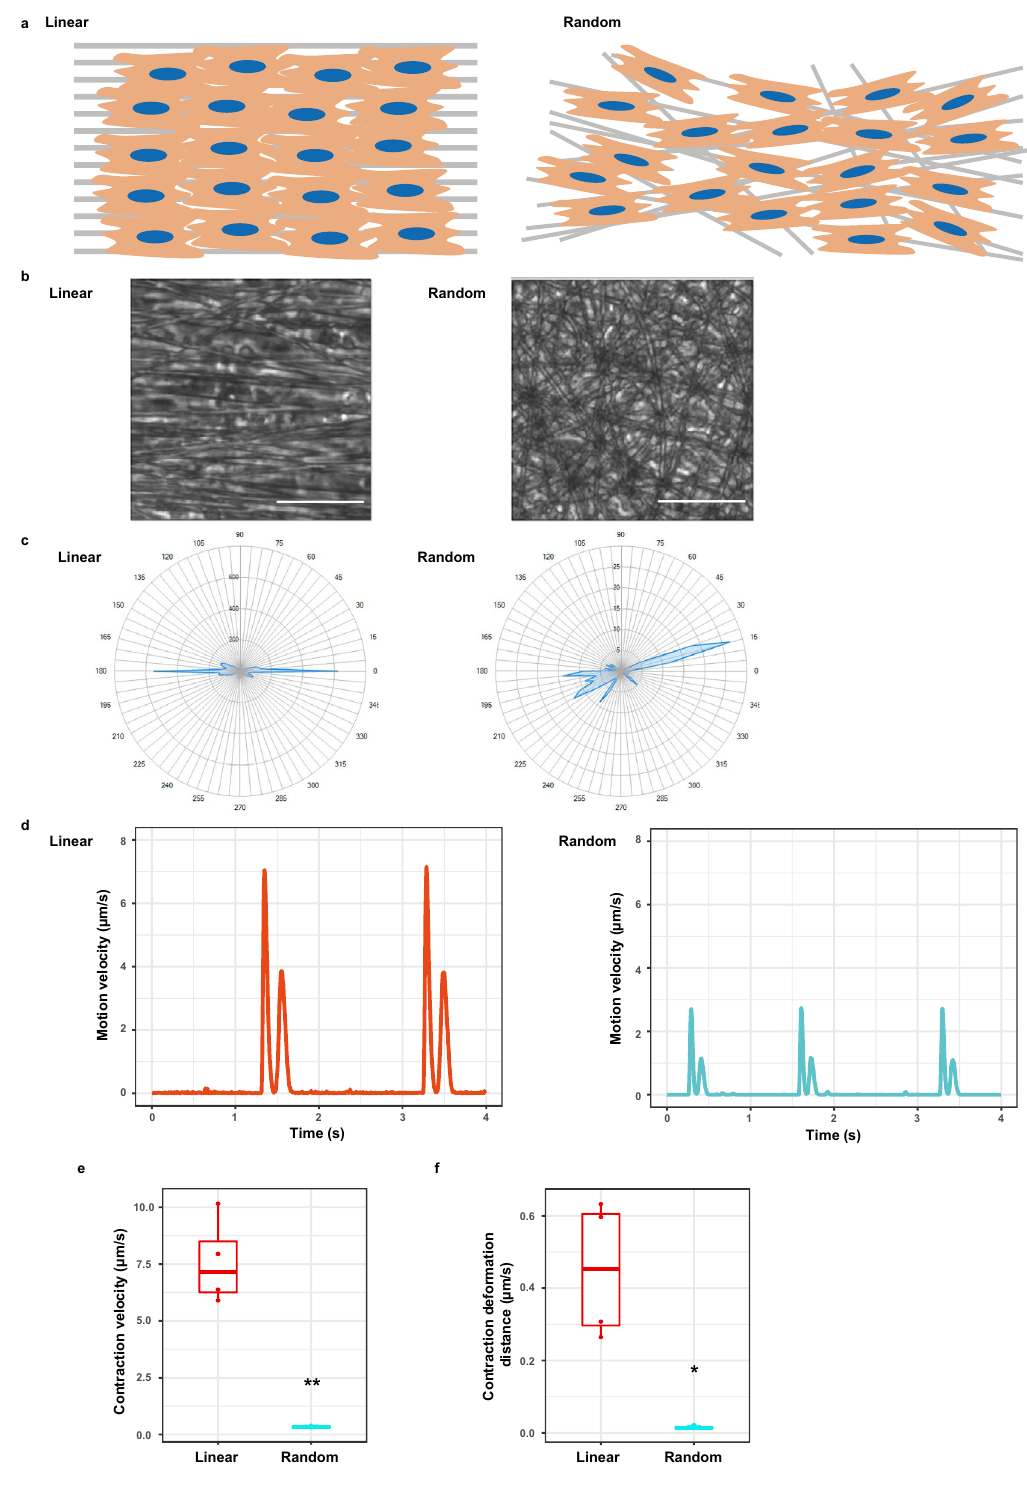
Figure 4. Homogeneous cardiomyocyte alignment in 2D generated greater contractility. ( a ) Cartoons of linearly and randomly aligned substrates. Neonatal rat cardiomyocytes (NRCMs) were seeded on top of them and cultured for 7 days. ( b ) Representative bright filed images of linearly and randomly aligned NRCMs. Scale bar, 50 μm. ( c ) Motion direction maps of linearly and randomly aligned NRCMs. The distribution of motion directions can be seen in these maps. ( d ) The motion velocity time-dependent curves of linearly and randomly aligned NRCMs in the 256 × 256-pixel region of interest (ROI). In each beating wave cycle, the first and second peak represented maximum contraction velocity and relaxation velocity, respectively. ( e,f ) Comparison of contraction velocity and contraction deformation distance of linearly and randomly aligned NRCMs. Contraction velocity ( e ) and contraction deformation distance ( f ) were statistically analysed (biological replicates = 4 each). Statistical significance was determined by unpaired two-tailed Student’s t-test. ** P < 0.01, * P < 0.05 versus linearly aligned NRCMs. A box and a line above/below the box indicate SD and 95% confidence interval, respectively. All statistical analyses were performed with the R software and ( d–f ) were created using the R